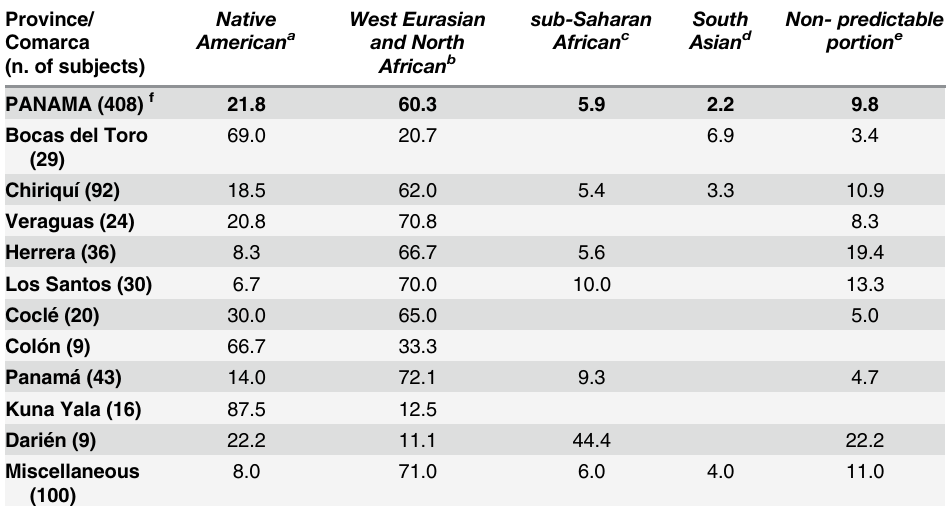
Table 3. Y-chromosome components (%) in the Panamanian samples with PGF in Panama.